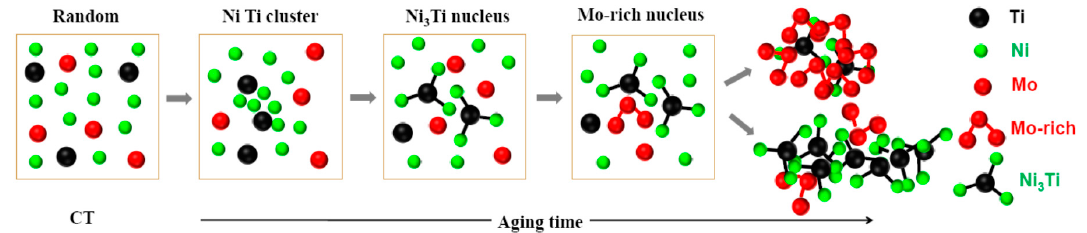
Figure 8. Schematics showing precipitation mechanism of Ni 3 Ti and Mo-rich phases in the new maraging stainless steel.